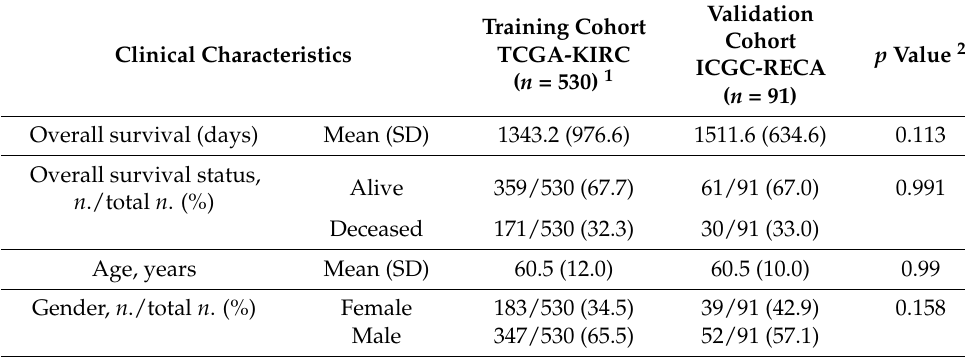
Table 1. Study Characteristics of TCGA-KIRC and ICGC-RECA cohort with the clinical characteristics: age, gender, tumor grade, metastasis, and staging by the American Joint Committee on Cancer